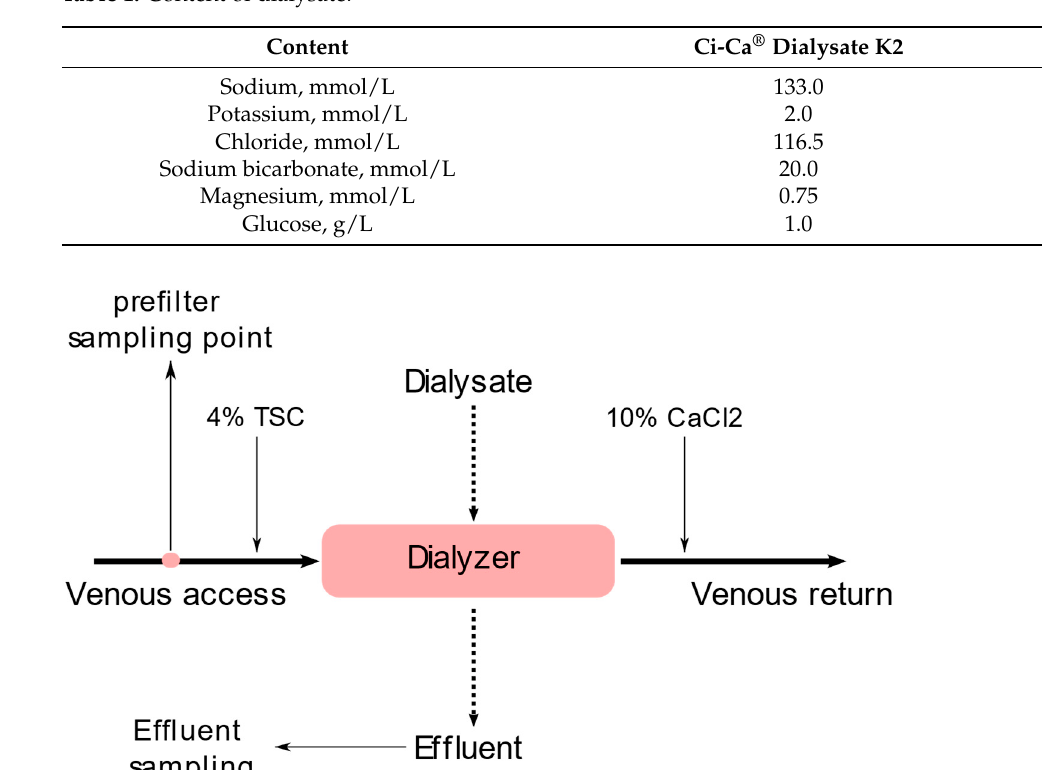
Table 1. Content of dialysate.